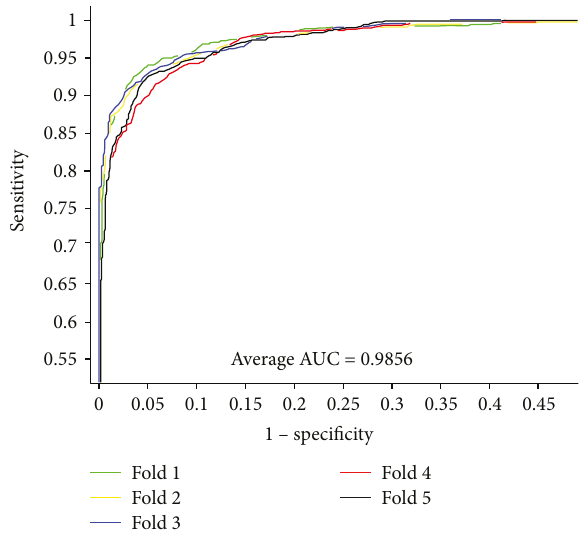
Figure 4: ROC curves performed by the proposed approach on the H. pylori dataset.